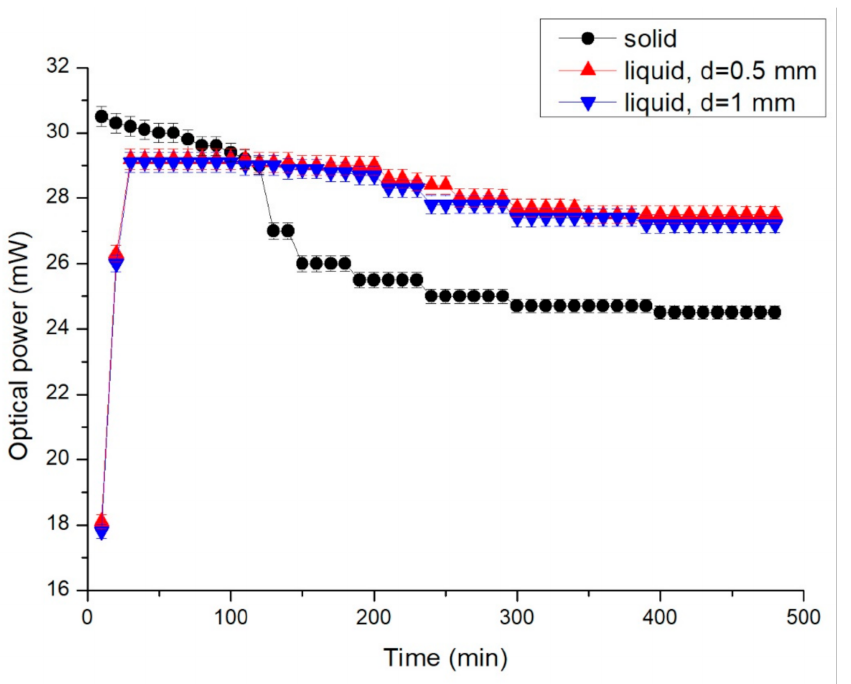
Figure 11. Optical power of the LED chip with various conductors and distances between